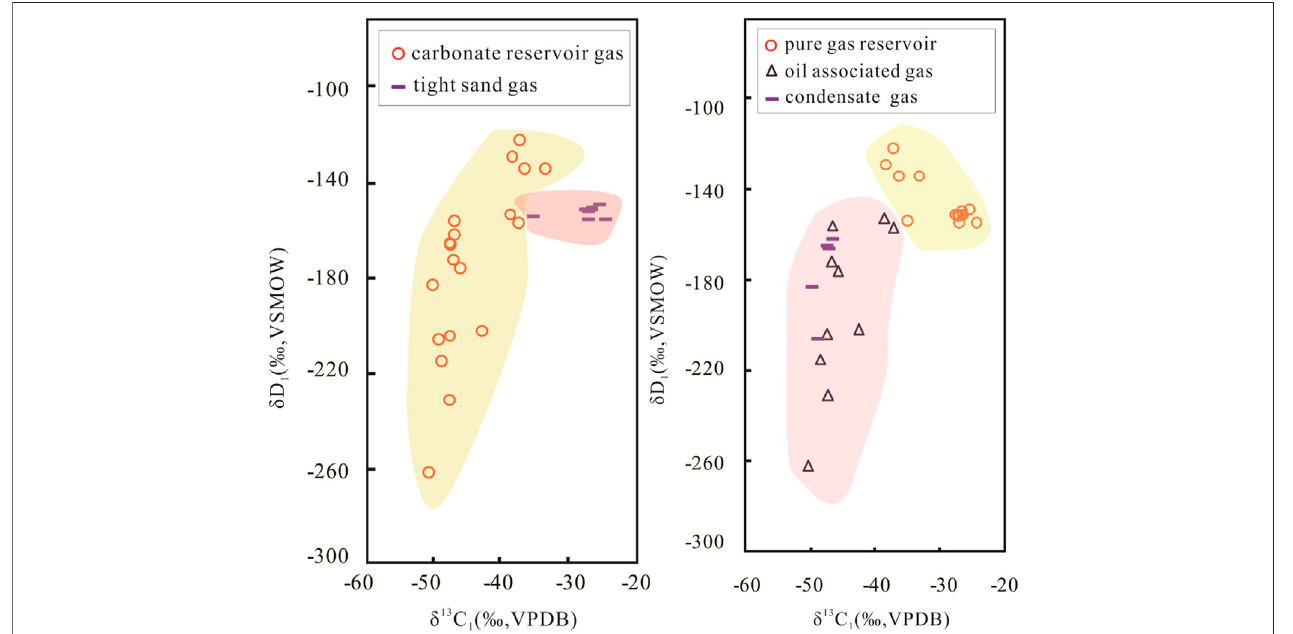
FIGURE 6 | δ 13 C 1 - δ D 1 of deep natural gas in different states and in different reservoirs of Tarim Basin.